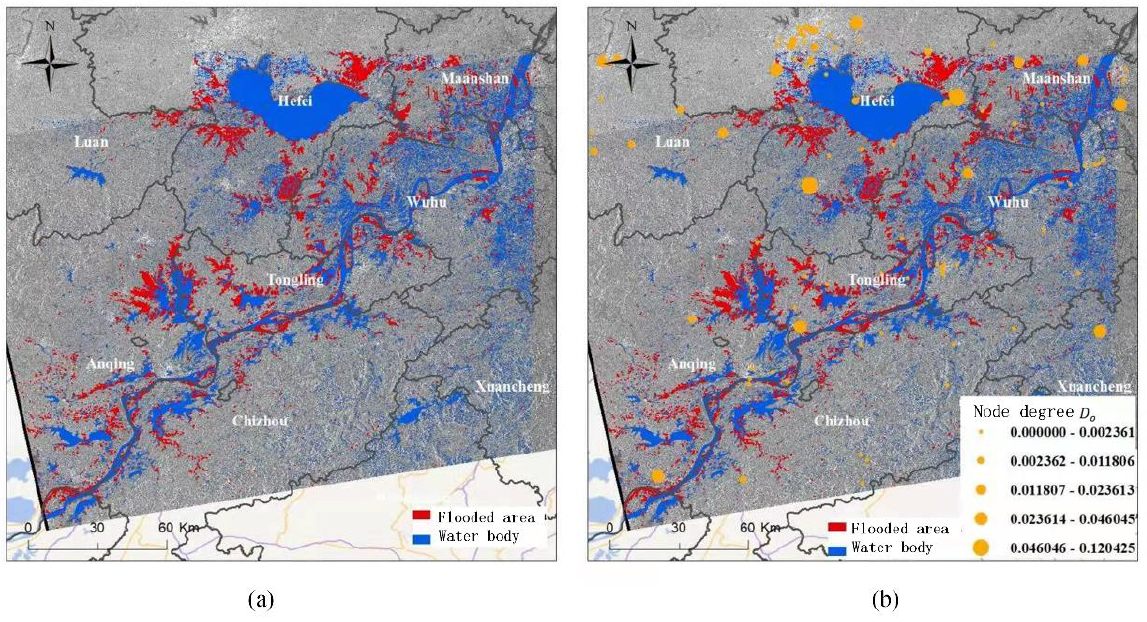
Figure 6. The spatial distribution relationship between social media data and flooded areas. Among them, ( a ) shows the flooded area based on remote sensing images; ( b ) overlays social media data, which have location tags, on a remote sensing image.